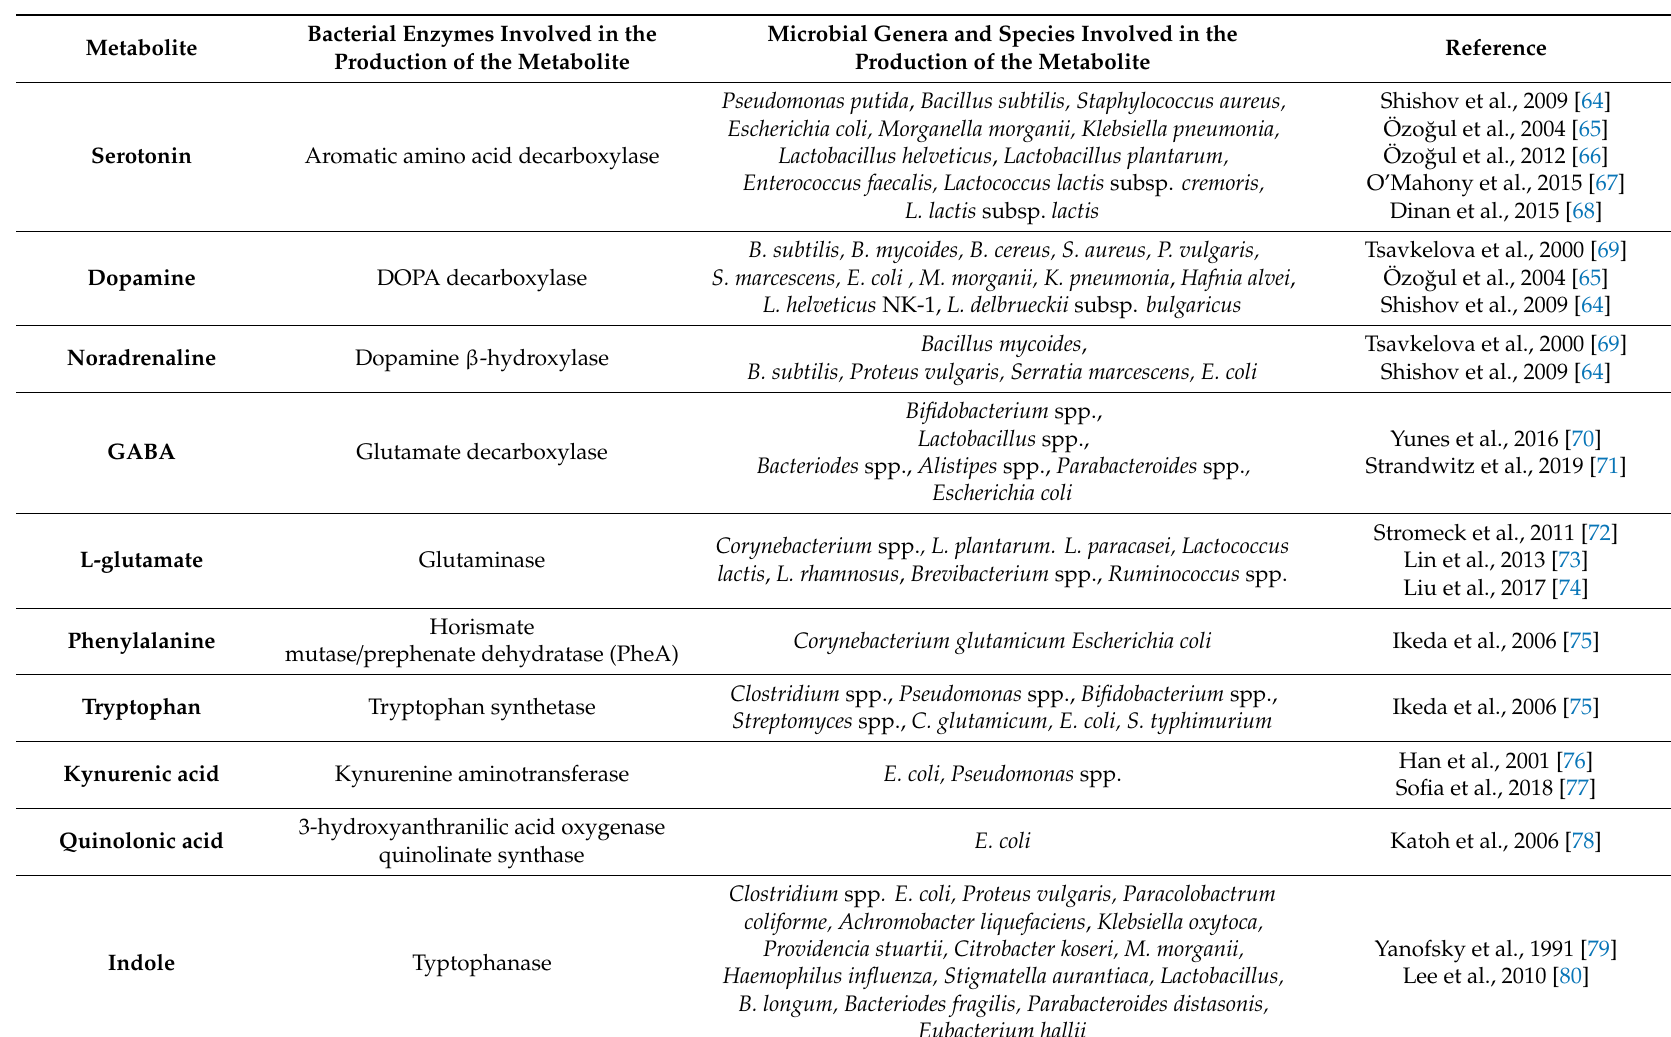
Table 1. Gut bacteria and their enzymes that are involved in the production of metabolites relevant to